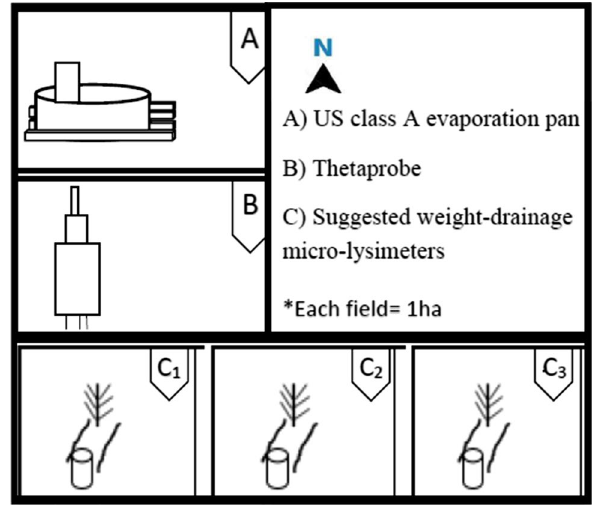
Fig. 4 Schematic view of three different crop water requirement methods in the field